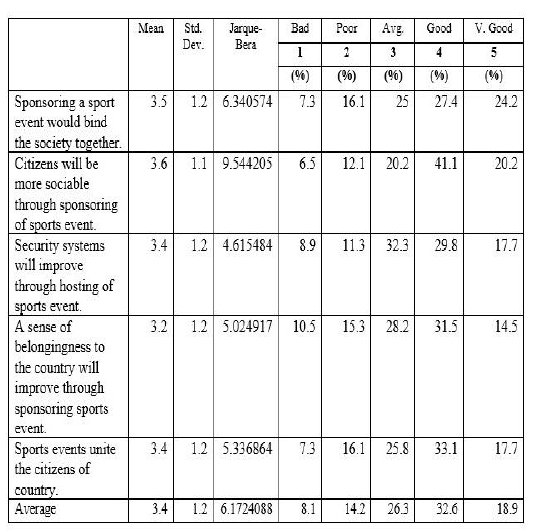
Table 6: Social Cohension